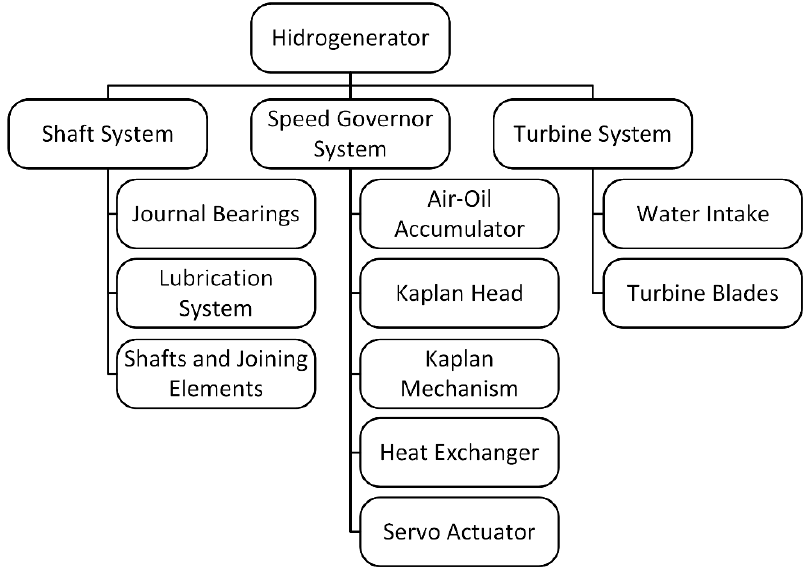
Figure 5. Analyzed system simplified functional tree.